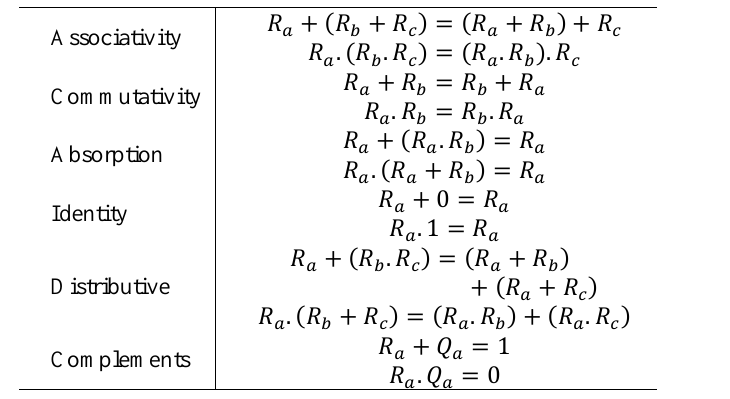
Table 2. The most important Boolean algebra rules for simplification of the